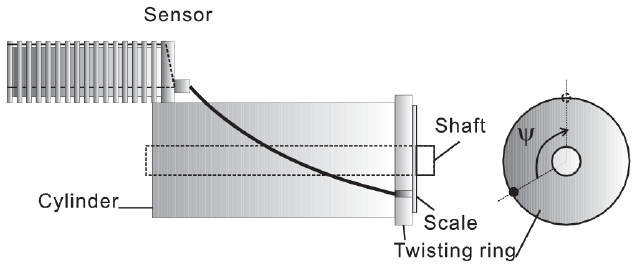
Figure 10. A structure imitates the measurement of torsion angle of shoulder